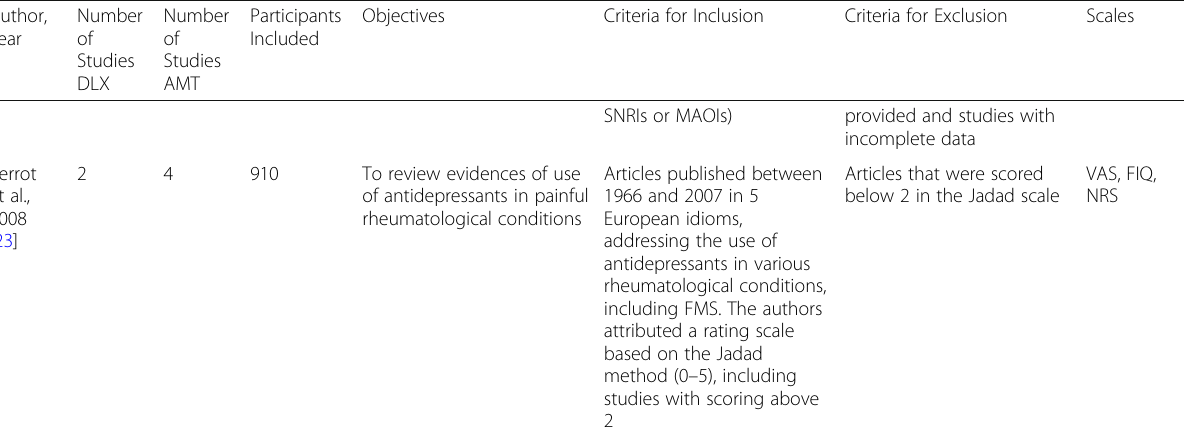
Table 1 Characteristics of the systematic reviews included (Continued)